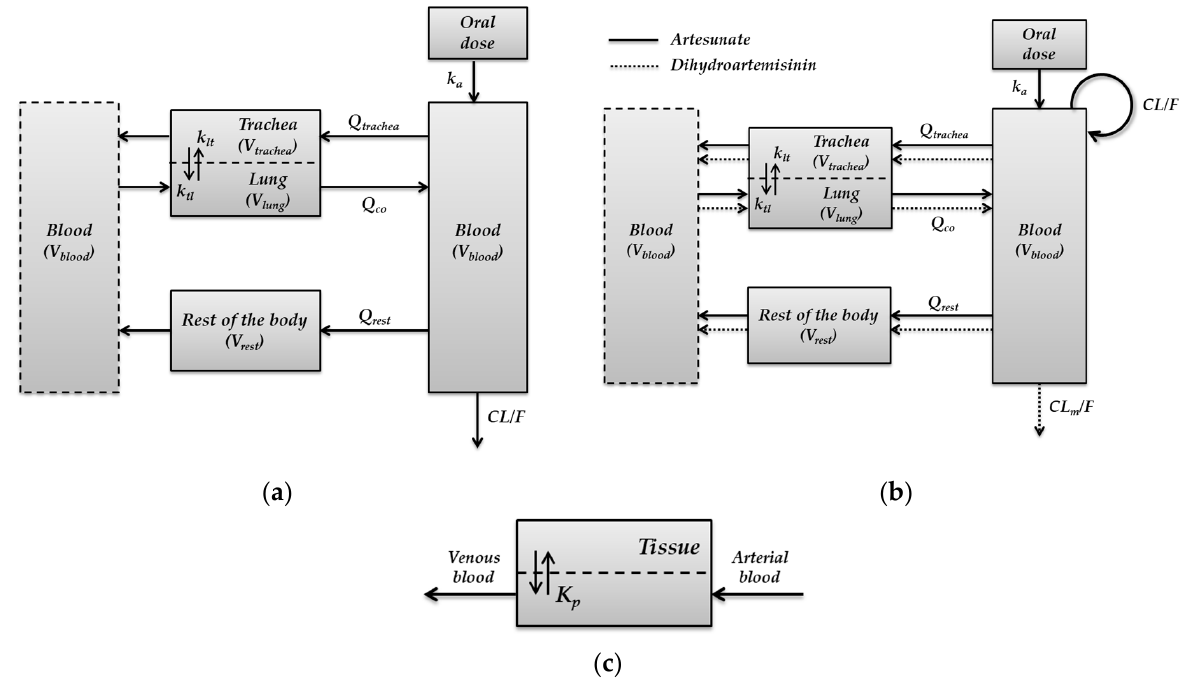
Figure 1. Structure of the minimal PBPK model for ( a ) pyronaridine, ( b ) artesunate, and dihy- droartemisinin in hamsters. ( c ) The perfusion rate-limited kinetics was used to describe the equi- librium between blood and tissue concentrations.